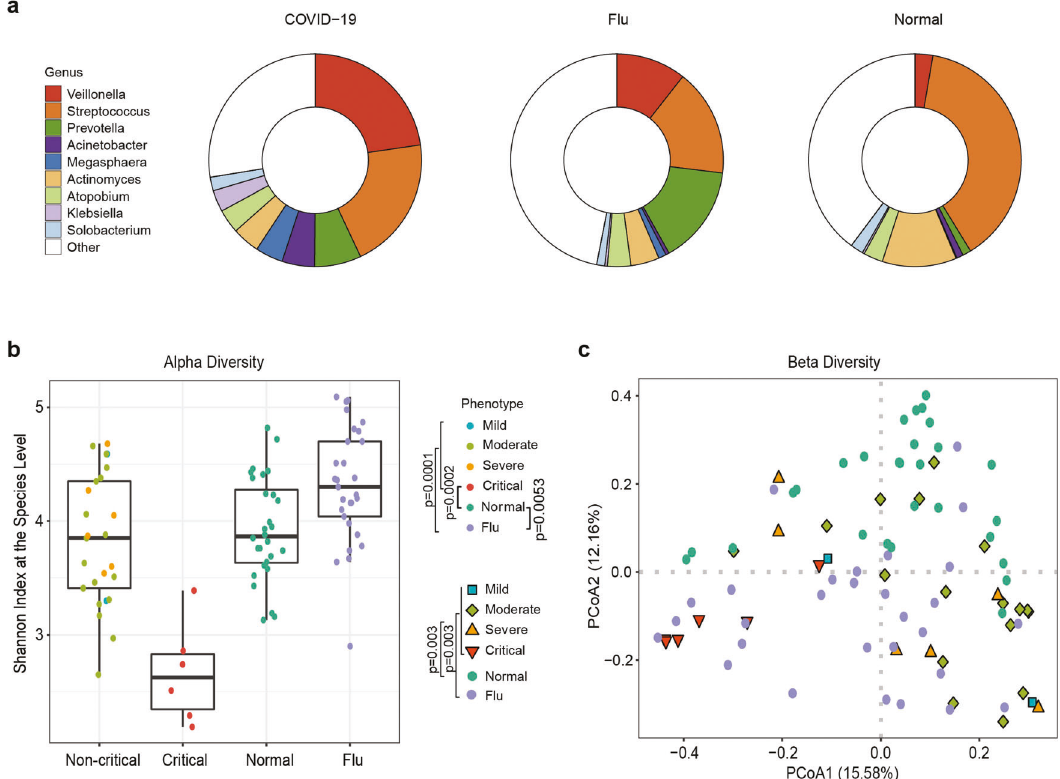
Fig. 1 Predominant bacterial composition in COVID-19 patients, fl u patients, and healthy controls with α -diversity and PCoA. a Fraction of predominant salivary microbiota with a relative abundance of at least 20% at the genus level in COVID-19 patients and their relative proportion in fl u patients and healthy controls. b α -Diversity in healthy controls (green), fl u patients (violet), noncritical COVID-19 patients (mild-blue, moderate-green, severe-orange), and critical COVID-19 patients (red) by the Shannon index at the species level. N mild = 2, N moderate = 17, N severe = 6, and N critical = 6. c First two axes of PCoA of the Bray distance from the β -diversity of healthy controls, fl u patients, and COVID-19 patients. Group differences were tested by pairwise permutational multivariate analysis of variation (PERMANOVA). Mild: blue squares; moderate: green diamonds; severe: orange triangle; critical: red inverted triangle: healthy: green circles; fl u: violet circles Signal Transduction and Targeted Therapy (2021)